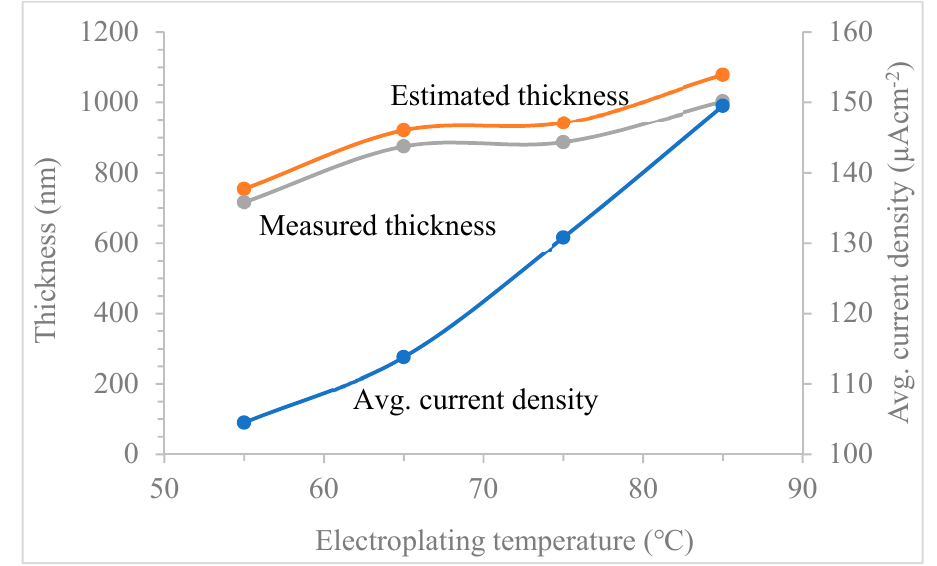
Figure 5. A plot of the estimated and measured thicknesses (as-deposited) and the average current density during electroplating against the electroplating temperature for CdTe layers grown for 180 min.